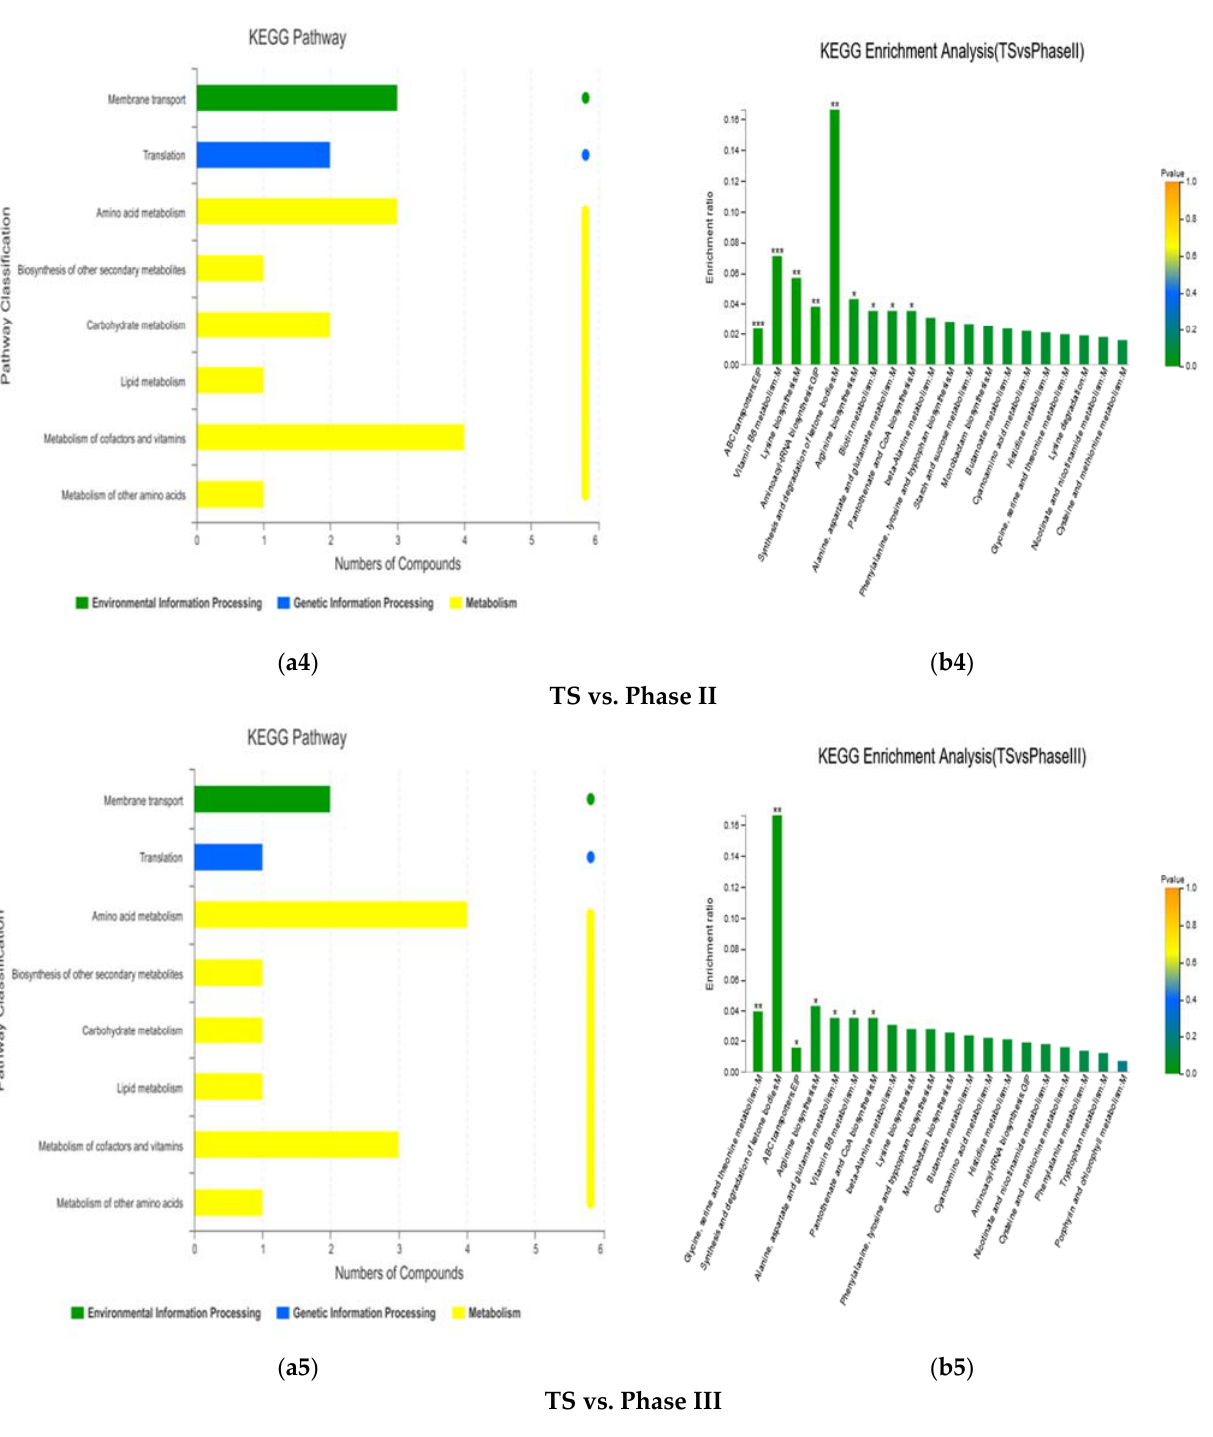
Figure 7. KEGG pathway and enrichment analysis of differential metabolites of the metabolic set. ( a1 – a5 ) represent the path analysis between comparison groups at different stages, and ( b1 – b5 ) represent the functional annotations between comparison groups at different stages.